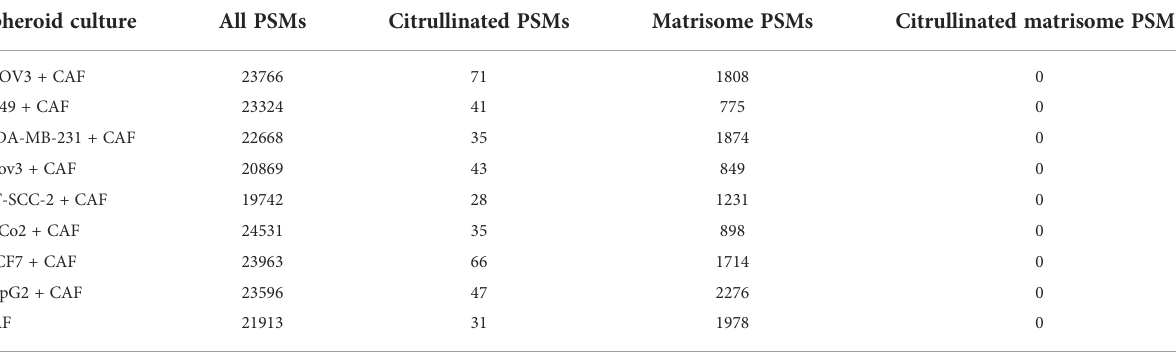
TABLE 3 Number of spectra matching to citrullinated or to all peptides obtained from the mass spectrometric analysis of spheroid cocultures of cancer cell lines and CAFs. Spheroid